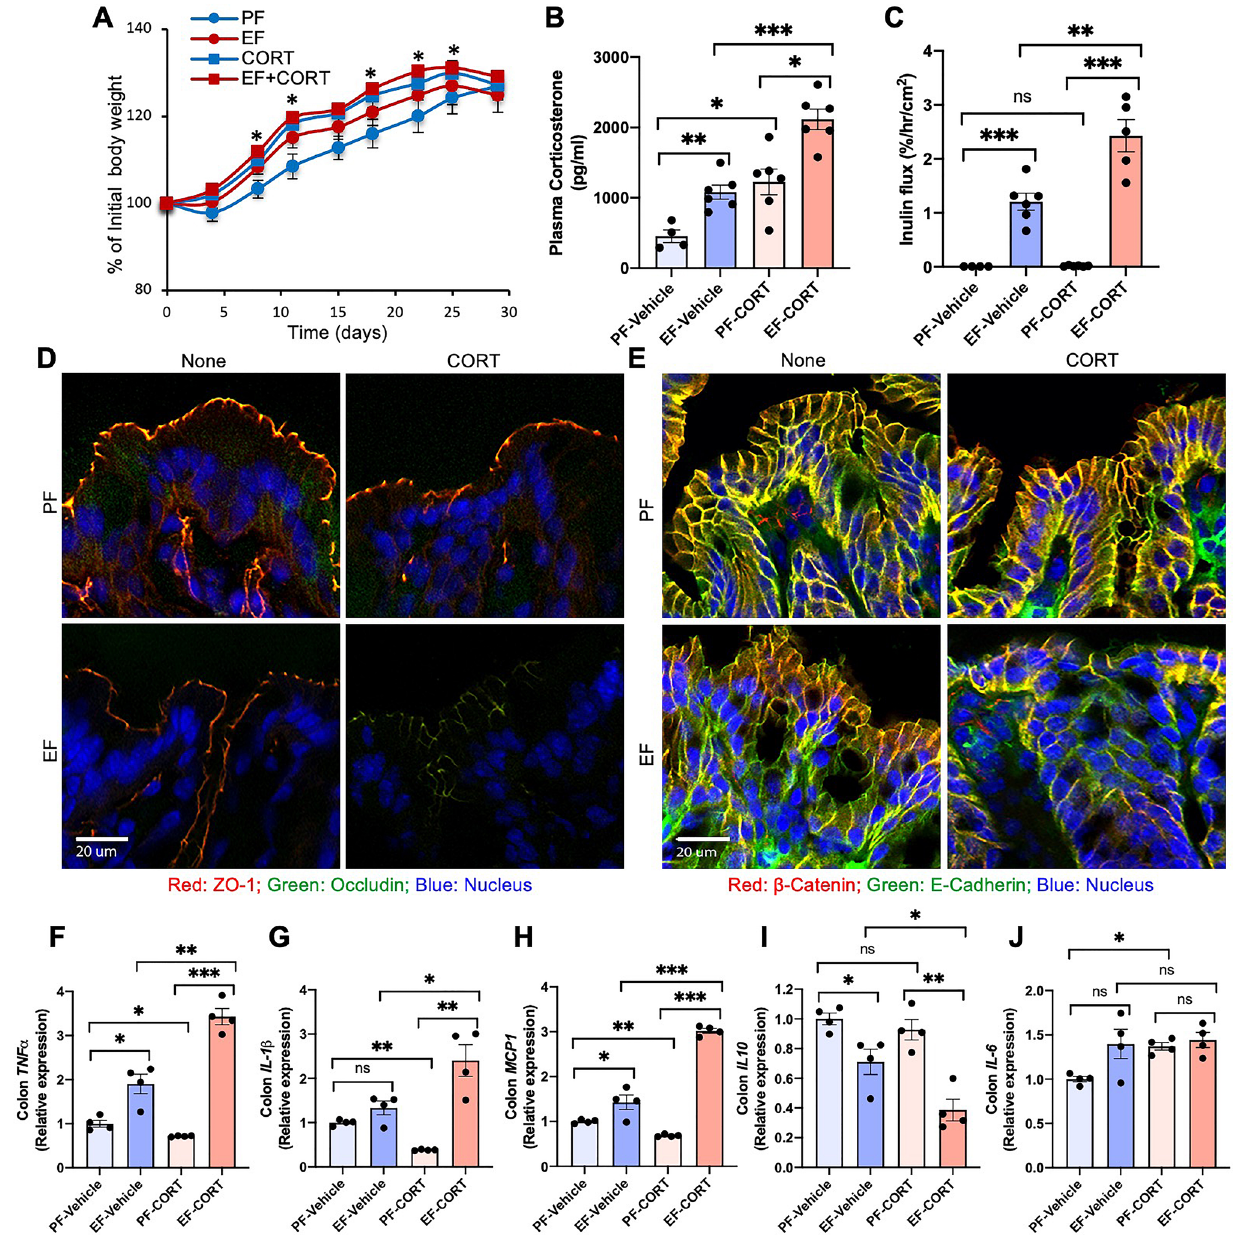
Figure 2. Corticosterone enhances alcohol-induced barrier dysfunction and mucosal inflammatory responses in the mouse colon. Adult mice were fed a liquid diet with (EF) or without (PF) ethanol for four weeks. In some groups, animals were injected with corticosterone (CORT) daily. Animals in other groups were injected with the vehicle. ( A ) Body weights were recorded twice a week. ( B ) Corticosterone levels were measured in plasma. ( C ) Mucosal permeability was measured by the vascular-to-luminal flux of FITC-inulin in the colon in vivo. ( D , E ) Epithelial junctional integrity was assessed by staining the cryosections of the colon for occludin and ZO-1 for tight junction ( D ) and E-cadherin and β-catenin for adherens junction ( E ) by immunofluorescence method followed by confocal imaging. ( F–J ) RNA isolated from colonic mucosa was analyzed for mRNA specific for TNFα ( D ), IL-1β ( E ), MCP1 ( F ), and IL-10 ( G ) by RT-qPCR. Values in graphs are mean ± SEM (n = 4–6 for A – C and 4 for F – J ). Dots in bars indicate individual values. The numbers above the bars are p -values for differences between the groups indicated by the horizontal lines, and "ns" indicates no significant difference between